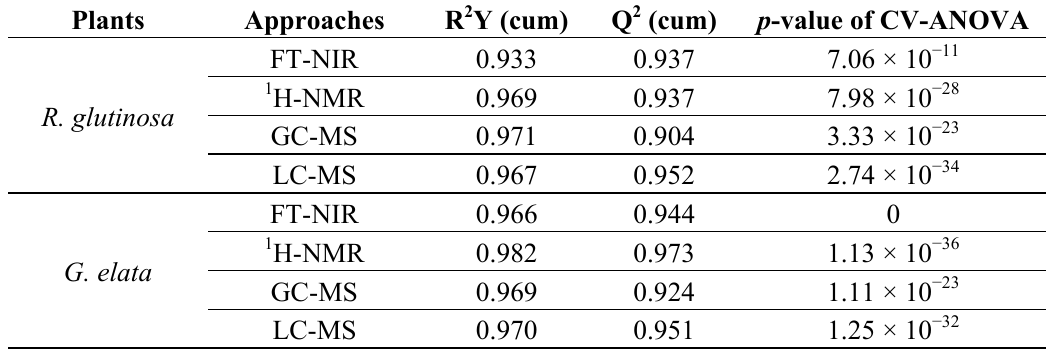
Table 5. Validation of the OPLS-DA models and CV-ANOVA values of each model to manifest the model’s